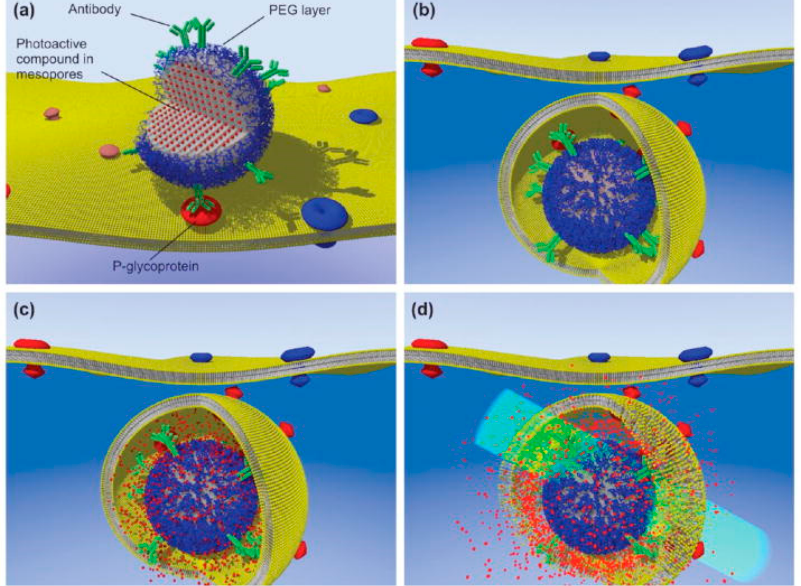
Figure 5. Schematic of light-activated and targeted cytosolic delivery of membrane-impermeable compounds. ( a ) Antibody-functionalized NPs are loaded with fluorescent Alexa546 model dye and targeted to cells expressing P-gp-green fluorescent protein (GFP bound to the P-glycoprotein transporter). After NPs endocytosis ( b ), the cargo was released in the endosome ( c ). Exposure to light at the dye’s excitation wavelength (546 nm) promoted ROS-mediated membrane damage ( d ) with cytosolic delivery of Alexa546 exclusively in the P-gp expressing cells. Reprinted with permission from [87]. Copyright 2010 American Chemical Society.